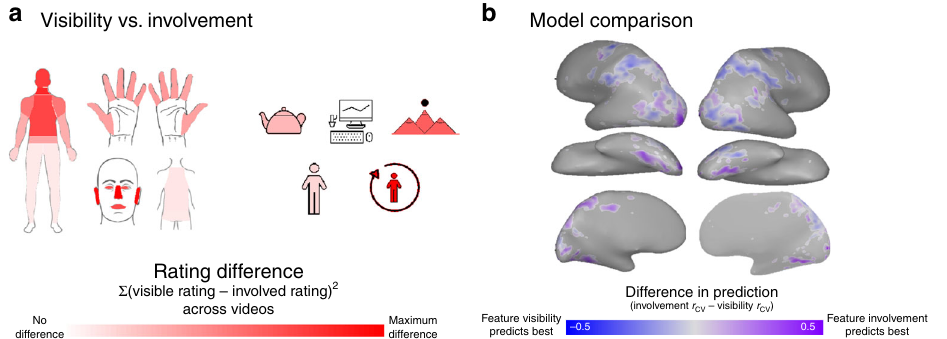
Fig. 6 The role of feature visibility. a Summary of feature-based differences between ratings of the features ’ visibility and involvement in the actions. Body parts and action targets that dissociate most strongly between ratings of visibility and involvement across our stimulus set are colored with the strongest saturation. Icons used to depict body part and target features were custom-made or based on images purchased from the Noun Project (Creative comparing prediction performance for the models based on feature involvement and visibility. Voxels are colored according to the model with the best cross-validated prediction performance: purple for the features ’ involvement, and blue for their visibility. Color saturation re fl ects the strength of the preference ( r CV for the involvement model — r CV for the visibility model). All brain fi gures were created by the